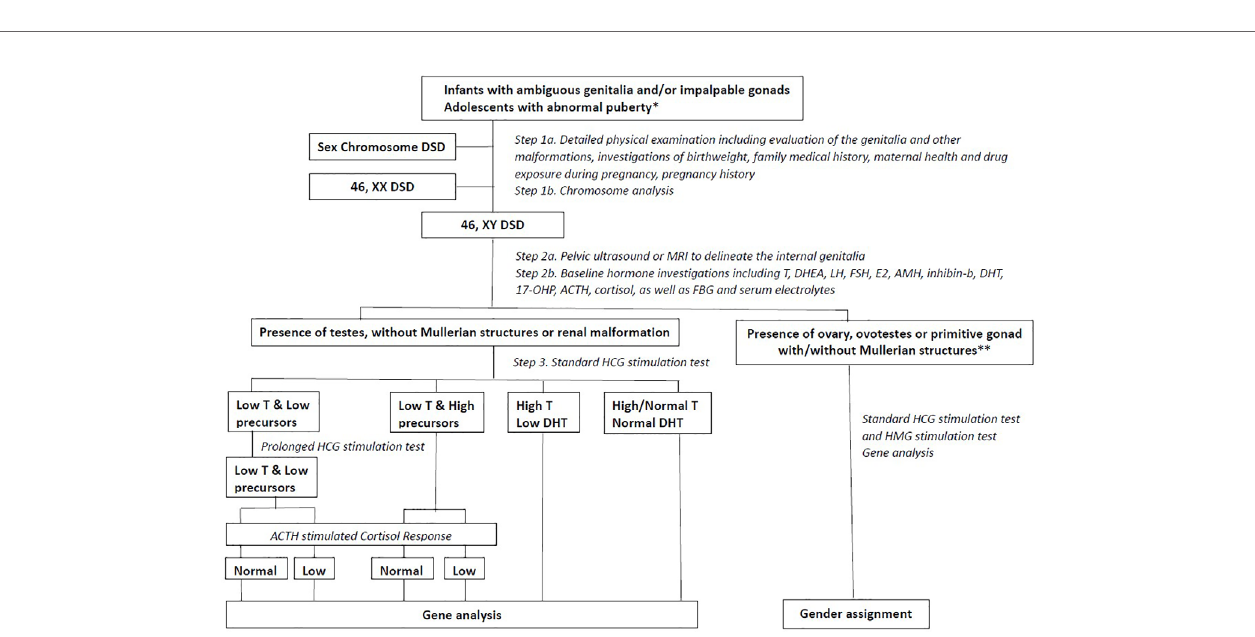
FIGURE 2 | The clinical evaluation algorithm of DSD patients. * abnormal puberty indicating that a girl with primary amenorrhoea with or without breast development, a girl who virilizes at puberty or a boy with pubertal delay; DSD, Disorders of Sex Development; FSH, Follicle Stimulating Hormone; LH, Luteinizing Hormone; T, Testosterone; DHEA, Dehydroepiandrosterone; E2, Estradiol; AMH, Anti-Mullerian Hormone; DHT, Dihydrotestosterone; 17-OHP, 17-OH-Progesterone; ACTH, Adrenocorticotrophic Hormone; FBG, Fast Blood Glucose; HCG, Human Chorionic Gonadotropin; HMG, Human Menopausal Gonadotropin; CHH, Congenital Hypogonadotropic Hypogonadism; Dysg, Gonadal Dysgenesis.